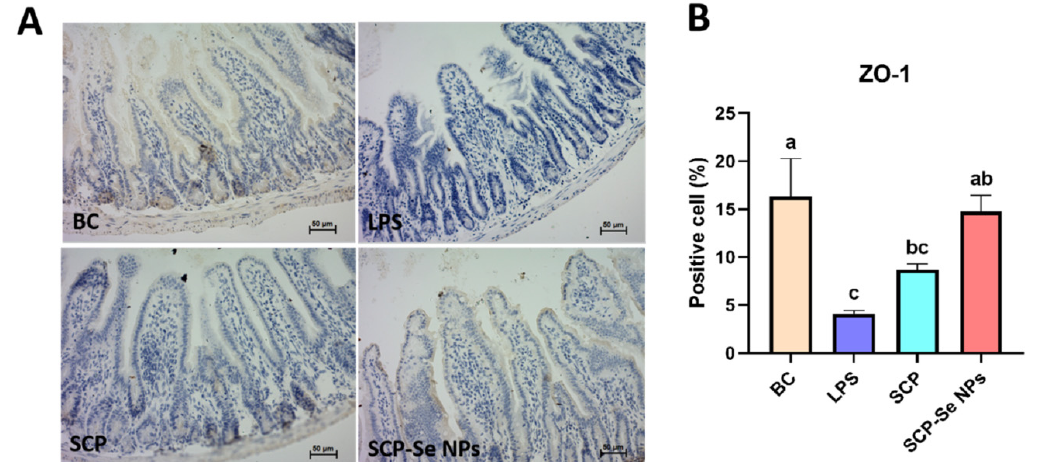
Figure 10. Influence of SCP-Se NPs on ZO-1 expression in LPS-induced intestinal injury. ( A ) IHC image results of jejunum ZO-1 expression in each group ( × 200 magnification). ( B ) Quantitative anal- ysis of jejunum ZO-1 expression in each group. Different lowercase letters (a–c) indicate significant differences ( p < 0.05).